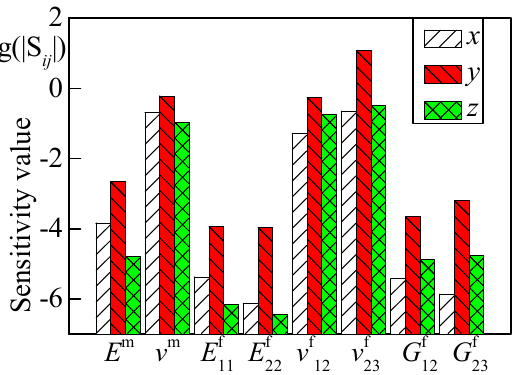
Figure 12. Sensitivity for displacements in respect to constituent parameters. Table 6. Condition number of relative sensitivity matrix for RVE.